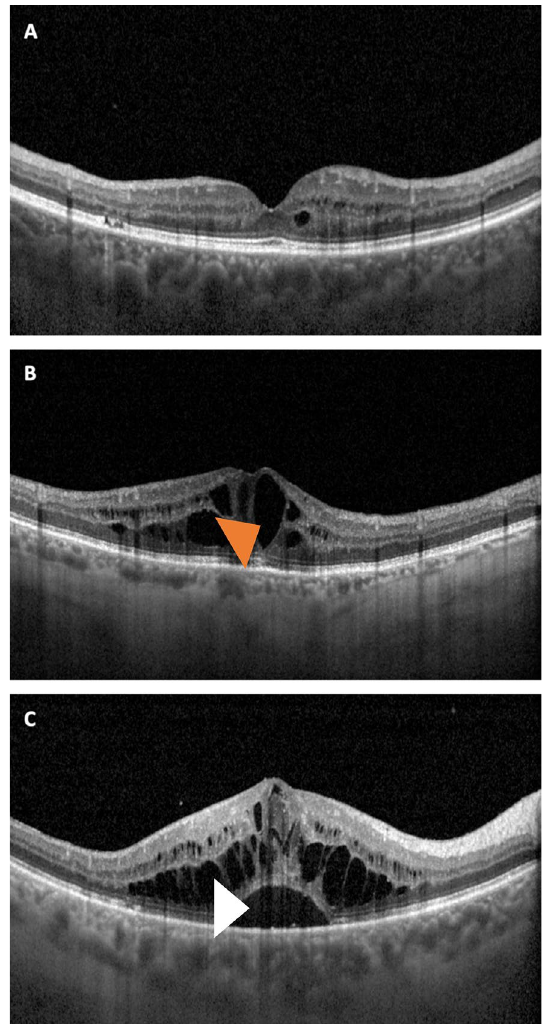
Figure 1. Clinical images showing structural OCT representations of the DME patterns. Representative horizontal optical coherence tomography (OCT) B-scan images through the fovea from three eyes with diabetic macular edema. OCT images were graded for qualitative features allowing characterization in different patterns that were investigated as prognostic factors influencing the longitudinal retinal thinning. Cases with intraretinal areas of reduced reflectivity were graded as being affected by diffuse macular thickening ( A ). Cases developing cystoid spaces (orange arrowhead) were graded as being characterized by cystoid macular edema ( B ). The evidence of an hyporeflective space below the neuroretina (white arrowhead) defined the presence of a subfoveal neuroretinal detachment ( C